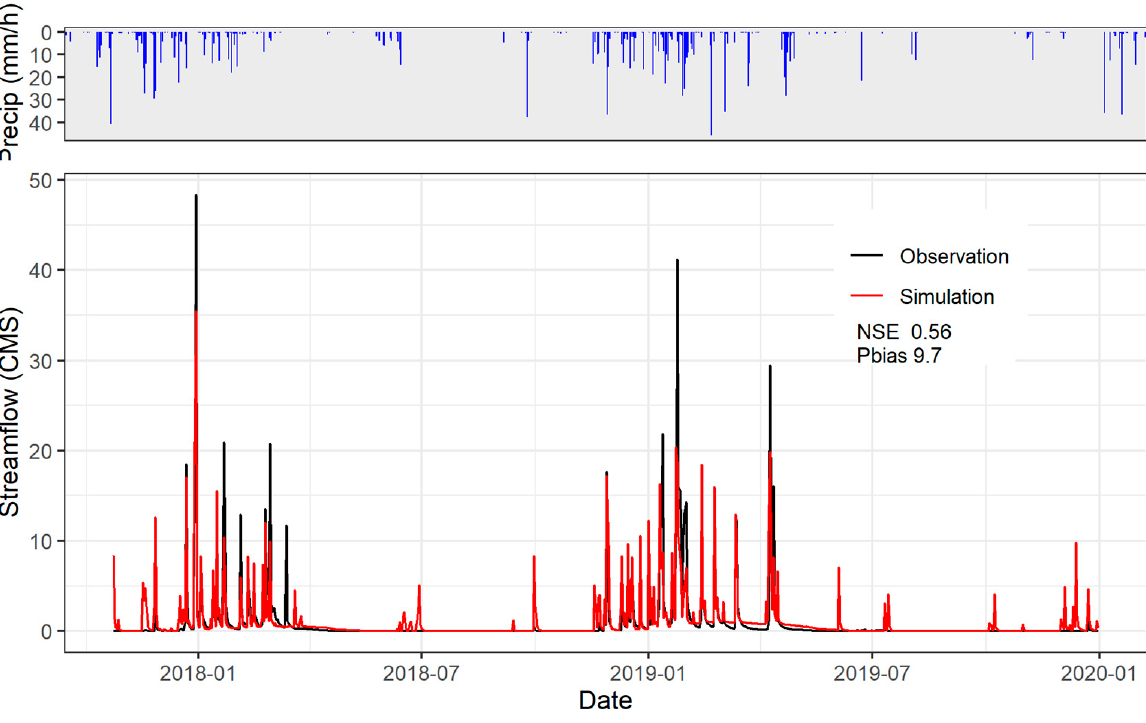
Figure 5. Measured and simulated daily discharge at Tsiknias River gauging station during calibration (2014–2016).